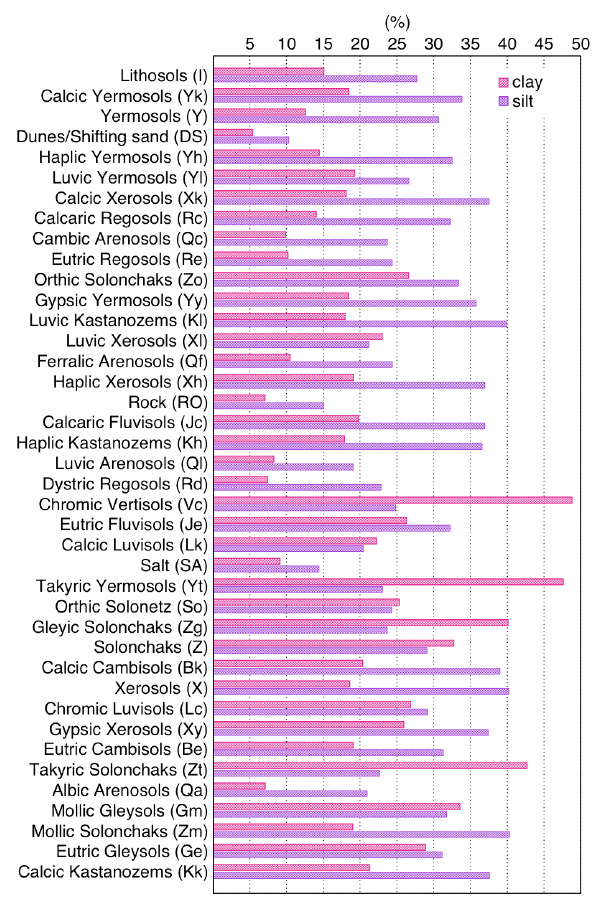
Figure 2. Global mean fractions of clay and silt for soil types listed in Fig. 1. 2 Fig. 2. Global mean fractions of clay and silt for soil types listed in Fig.